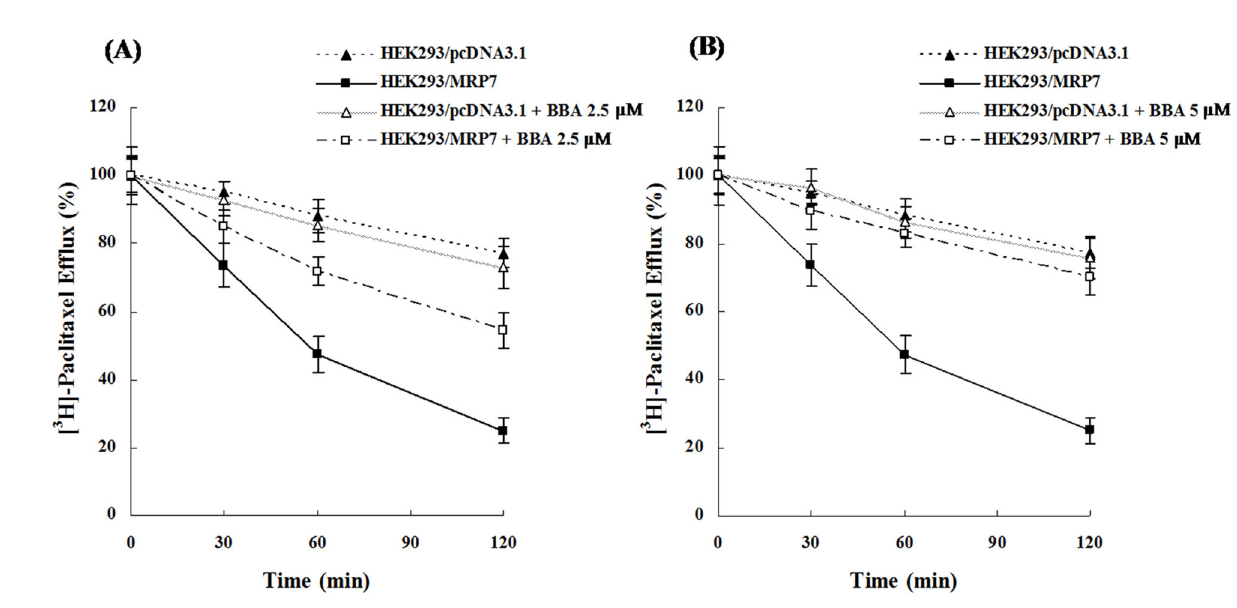
Figure 5. BBA inhibits the efflux of [ 3 H]-paclitaxel mediated by MRP7 in HEK293/MRP7 cells. Cells were pre-incubated with or without BBA at 2.5 µM (A) or 5 µM (B) for 2 h at 37 °C and further incubated with 0.1 µM [ 3 H]-paclitaxel for another 2 h at 37 °C. Cells were then incubated in the fresh medium with or without BBA at 2.5 or 5 µM for different time periods at 37 °C. Thereafter cells were collected and the intracellular levels of [ 3 H]-paclitaxel were measured by scintillation counting. A time course versus percentage of intracellular [ 3 H]-paclitaxel was plotted (0, 30, 60 and 120 min). Data points represent the means ± SD of triplicate determinations. Experiments were performed at least three independent